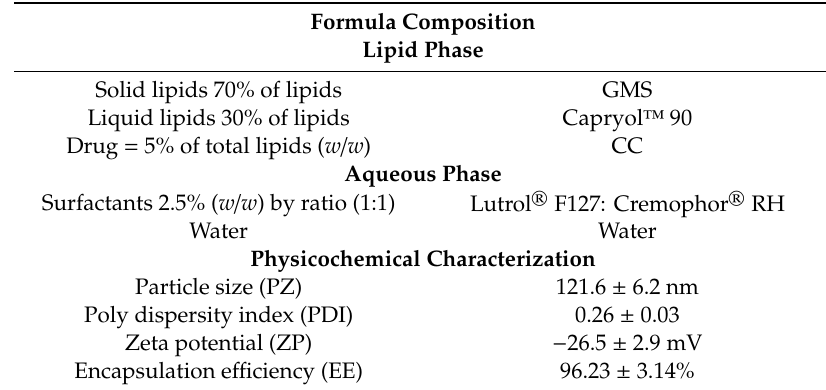
Table 1. Composition and physicochemical characterization of Candesartan Cilexetil (CC) successfully encapsulated into a nanostructured lipid carrier